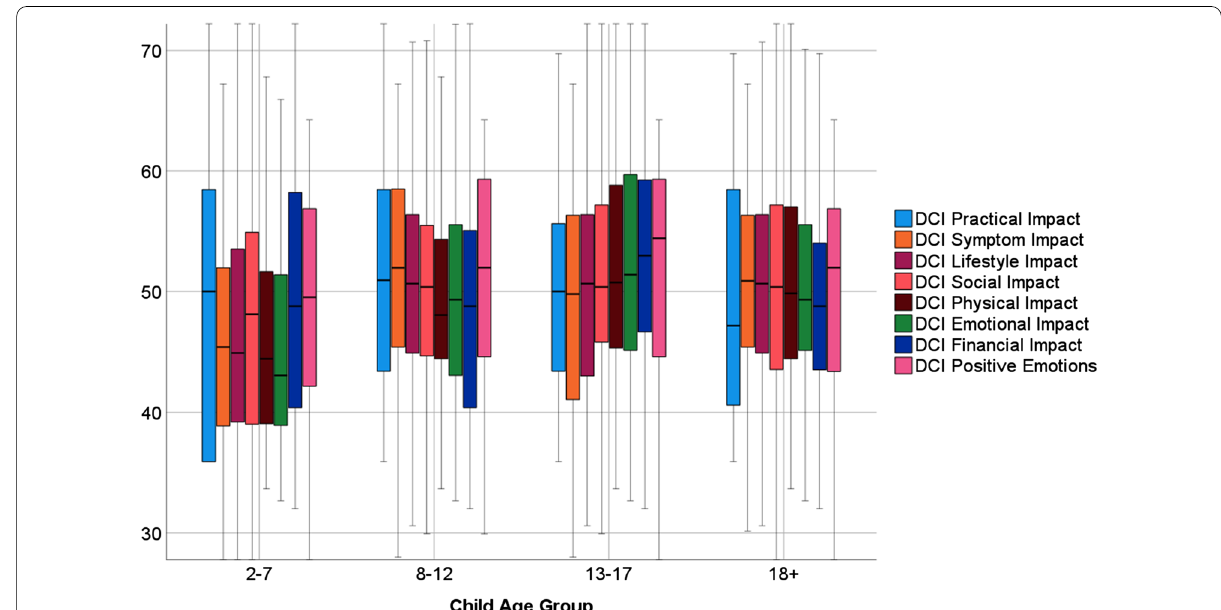
Fig. 1 DMD Caregiver Impact (DCI) subscale scores by Child Age Group. These box-and-whiskers plots show the distributions of the eight DCI subscale scores by DMD Child Age Group strata. There were upward trends as the age of the index child increased through age 13–17, in all domains except Practical Impact and Positive